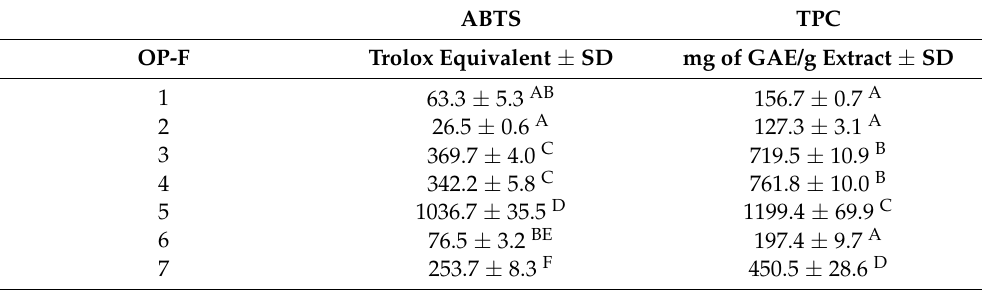
Table 6. The radical scavenging activity of the seven fractions obtained from OP-W1, the aqueous absorbable OP extract (OP-F) characterized by the highest antioxidant properties. Values are reported as Trolox equivalent ( µ g TE/mg dry